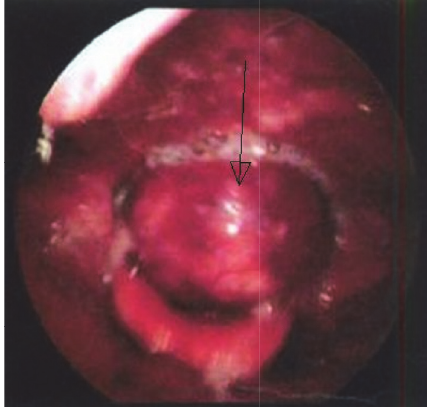
Figure 1: Laryngoscopy showing a pedunculated mass coming from laryngeal inlet.